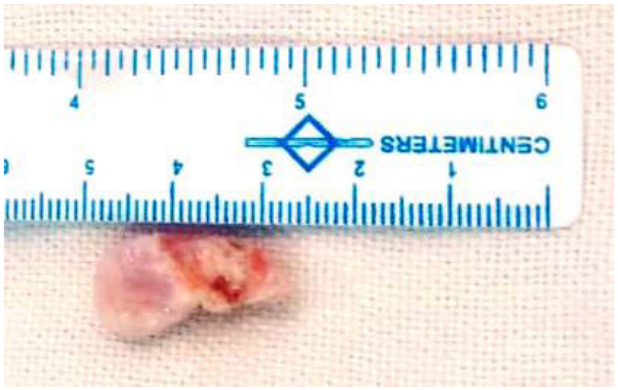
Fig. 3 – Specimen of pedunculated mass.